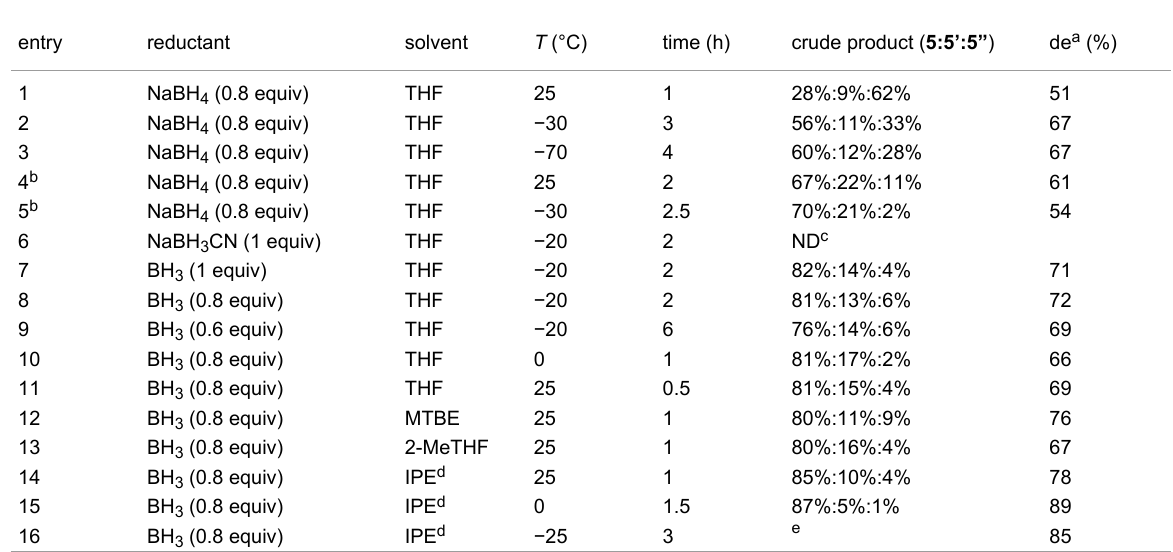
Table 1: Conditions for the reduction of sulfinylimine 4